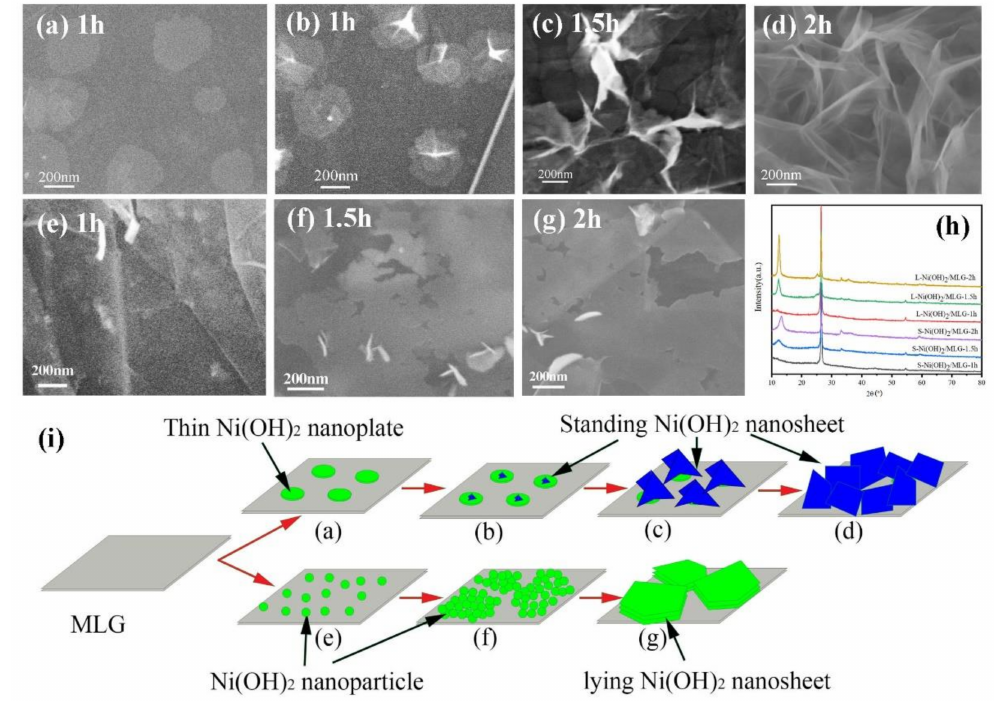
Figure 5. Scanning electron microscope (SEM) images of S-Ni(OH) 2 /MLG ( a – d ) and L- Ni(OH) 2 /MLG ( e – g ) with different reaction time, and their X-ray diffraction (XRD) patterns ( h ), as well as the suggested schematic growth processes ( i ), Schematic diagrams (a–g) in (i) correspond to SEM images (a–g),